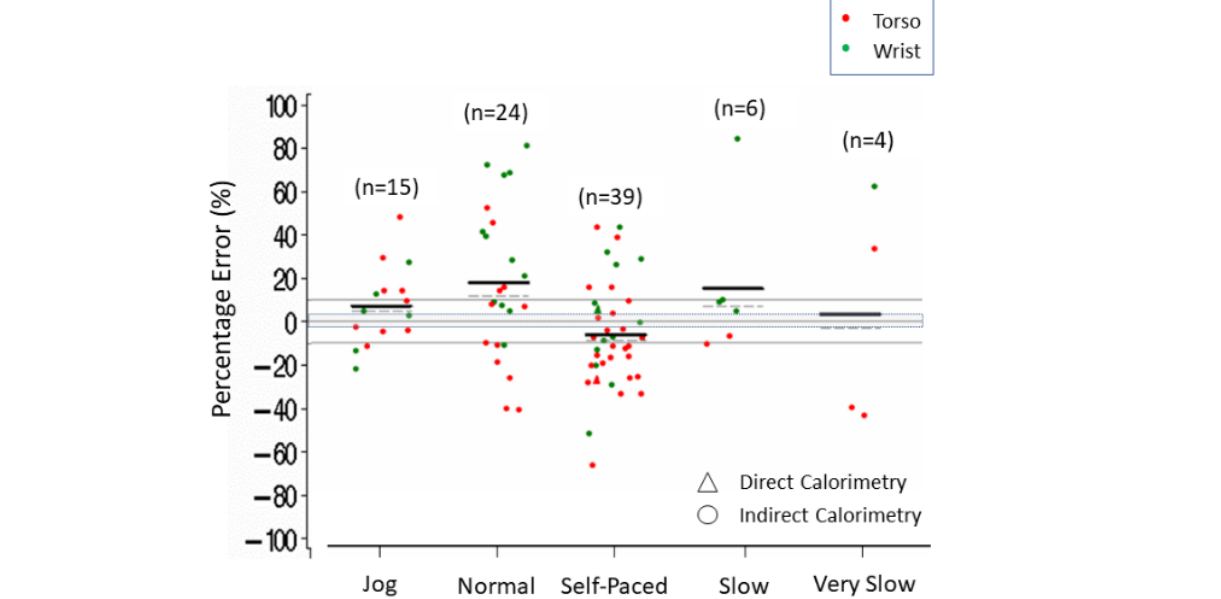
Figure 8. Energy expenditure percentage error in controlled settings. Speed (jog, normal, slow, self-paced, very slow) by body placement (torso, wrist). Dark lines indicate mean (horizontal). Dashed lines indicate median (horizontal). Triangles indicate measurement by direct calorimetry. Gray shading indicates ±3% measurement